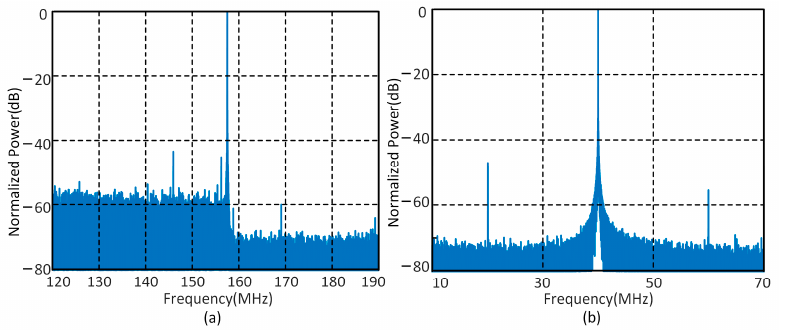
Figure 8. The normalized power spectrum density of the de-chirped signal ( a ) and the down-converted signal ( b ).